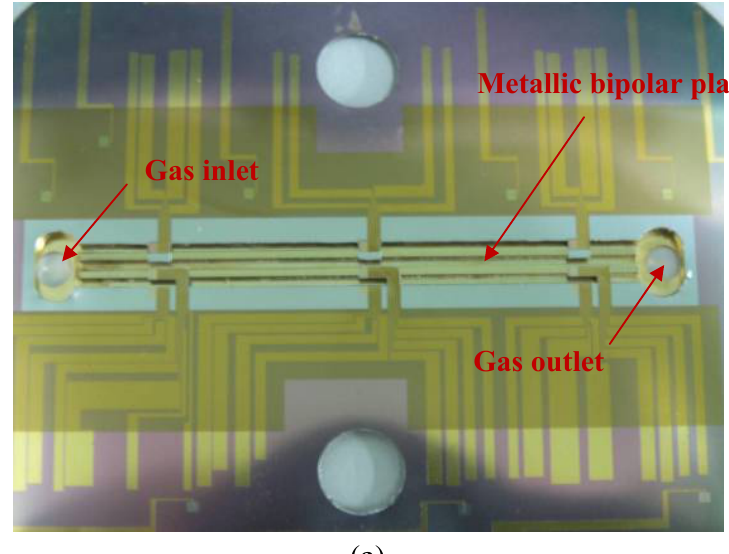
Figure 5. Completed micro sensor foil: ( a ) sensor foil with stainless steel bipolar plate, and ( b ) micro sensors at the under-the-rib